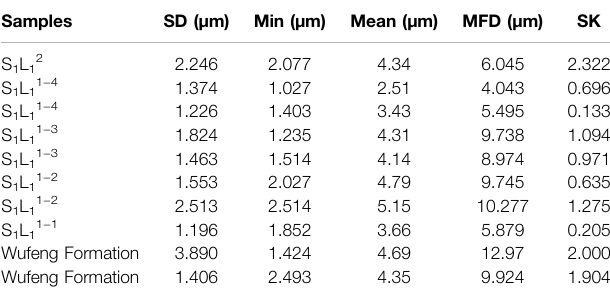
TABLE 1 | Pyrite framboid size distributions via SEM images and Corephic v2.1 software measurement. SD = standard deviation; MFD = maximum framboid diameter; SK =